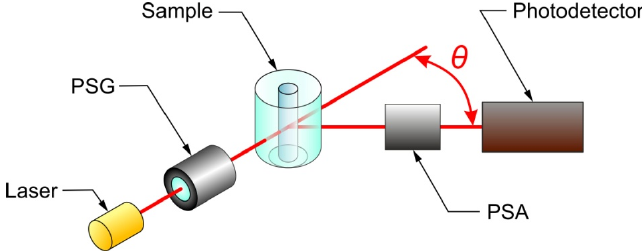
Figure 2. Simplified scheme of an MM scatterometer.